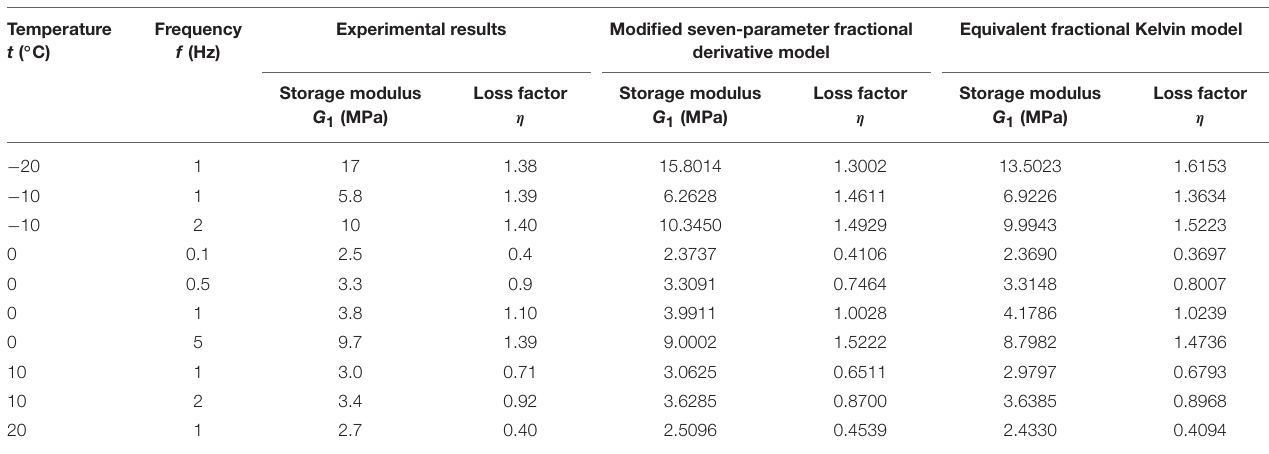
TABLE 4 | Experimental and numerical results comparison for 9050A viscoelastic